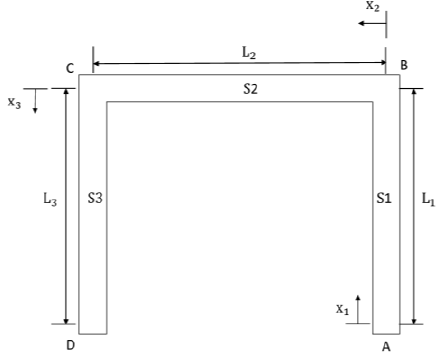
Figure 5. Top view of Part 1 of the coil.